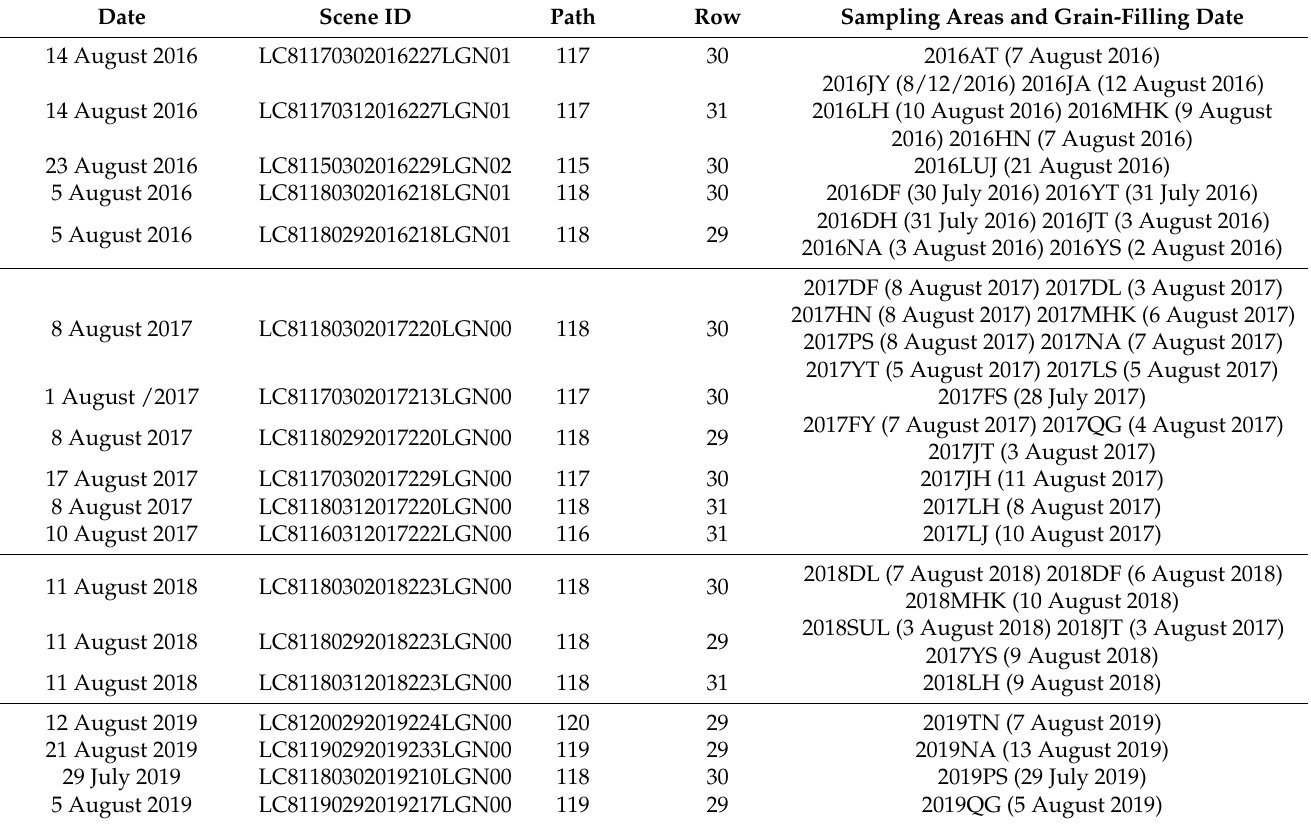
Table 1. Information about selected Landsat 8 OLI